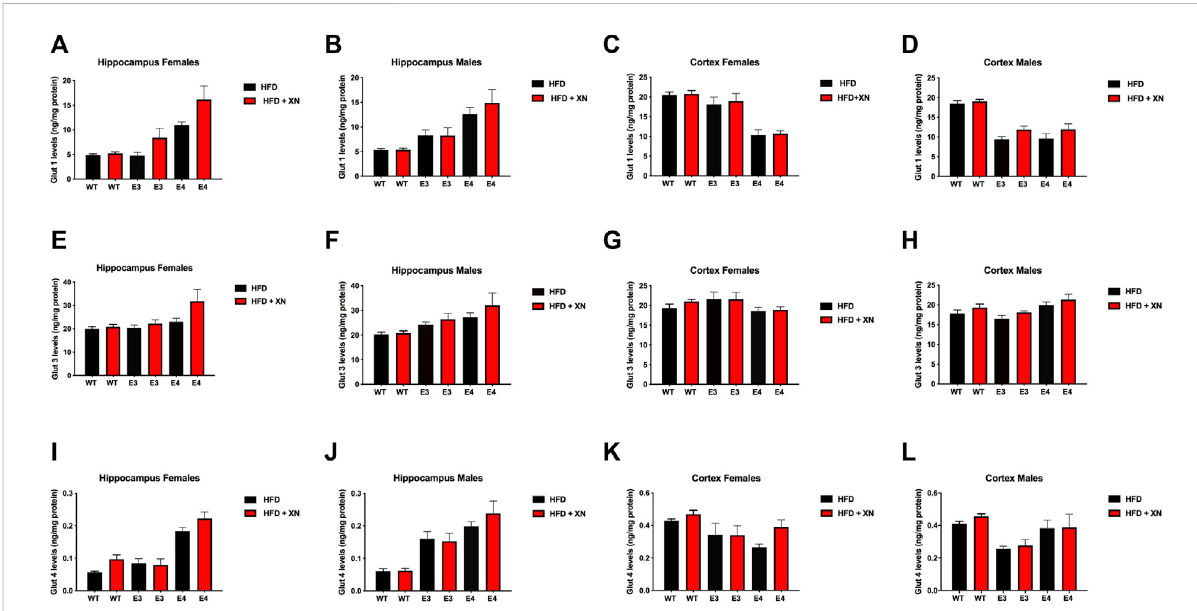
FIGURE 5 Protein levels of GLUT1 (A – D) , GLUT3 (E – H) , and GLUT4 ( I – L ) glucose transporters in the hippocampus (A,B,E,F,I,J) and cortex ( C,D,G,H,K,L ). All graphs show the mean ± SEM. XN-treated mice had higher glucose transporter protein levels in the hippocampus and cortex than HFD only- treatedmice,with theexceptionofE3mice. Amongthe12 sex-genotype-sitecombinations foreachofthe3glucosetransporters,XN-treated mice had for 31 of 36 comparisons higher levels than HFD only-treated mice (sign test: p < 0.0001). In all WT and E4 mice comparisons, XN-treated micehadhigherlevels,whereasin5of12E3micecomparisons,HFDonly-treatedmicehadhigherlevels.TheXN-effectwassigni fi cantforGlut1( p = 0.01) and Glut3 ( p = 0.02) in the hippocampus and tended to be signi fi cant for Glut 4 ( p = 0.075) in the hippocampus and for Glut 3 ( p = 0.095) and Glut4( p =0.08)inthecortex.E4micehadhigherglucosetransporterproteinlevelsinthehippocampusandlowerglucosetransporterproteinlevels cortex than WT mice. In all 4 sex-treatment comparisons for each of the 3 glucose transporters, E4 mice had higher glucose transporter protein levelsinthehippocampus(signtest: p =0.0005),andin10of12comparisons,E4micehadlowerglucosetransporterproteinlevelsinthecortex( p = 0.04) than WT mice. E3 mice also had higher glucose transporter protein levels in the hippocampus and lower glucose transporter protein levels cortex than WT mice. In 10 of 12 comparisons, E4 mice had higher glucose transporter protein levels in the hippocampus (sign test: p = 0.04) and lower glucose transporter protein levels in the cortex (sign test: p = 0.04) than WT mice. Female and male E4 mice had higher glucose transporter protein levels in the hippocampus and female E4 mice had lower glucose transporter protein levels in the cortex than female E3 mice in all 18comparisons(signtest: p < 0.0001).TheexceptionwerecorticallevelsinmaleE4mice,whichwerehigherin5of6E4vs.E3comparisons(Fisher ’ s exact test: p = 0.0007). Male mice had higher glucose transporter protein levels in the hippocampus than female mice in 14 of 18 comparisons ( p = 0.03) and lower glucose transporter protein levels in the cortex than female mice in all 12 WT and E3 comparisons (sign test: p = 0.0005).